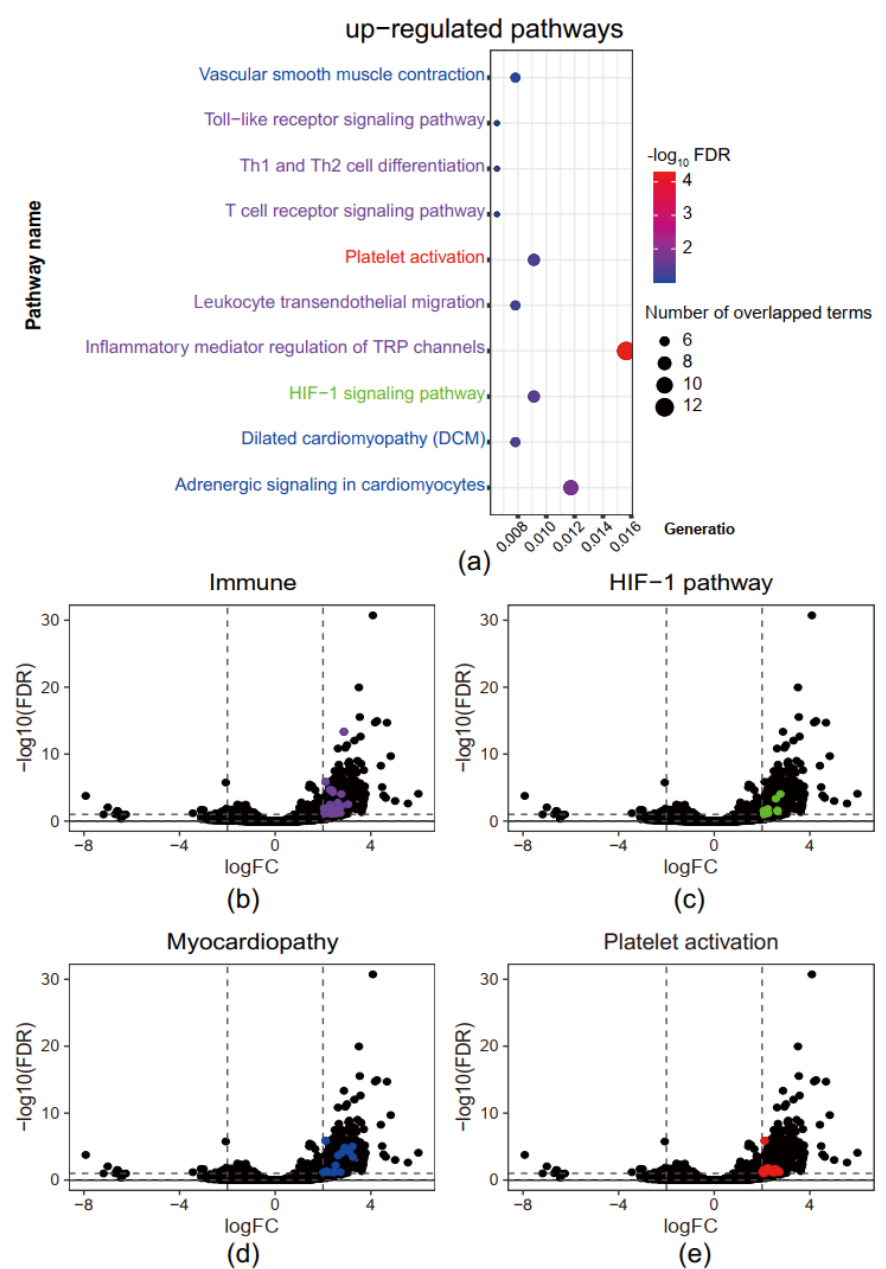
Figure 1. Immune, myocardiopathy, and hypoxia response-related pathways are up-regulated in superimposed PE ( a ) Kyoto Encyclopedia of Genes and Genomes (KEGG) pathway enrichment analysis of genes with higher chromatin accessibility ( b – e ) The volcano plot of immune, hypoxia response, hypertension, and platelet activation related gene. HIF-1 stands for Hypoxia Inducible Factor-1.